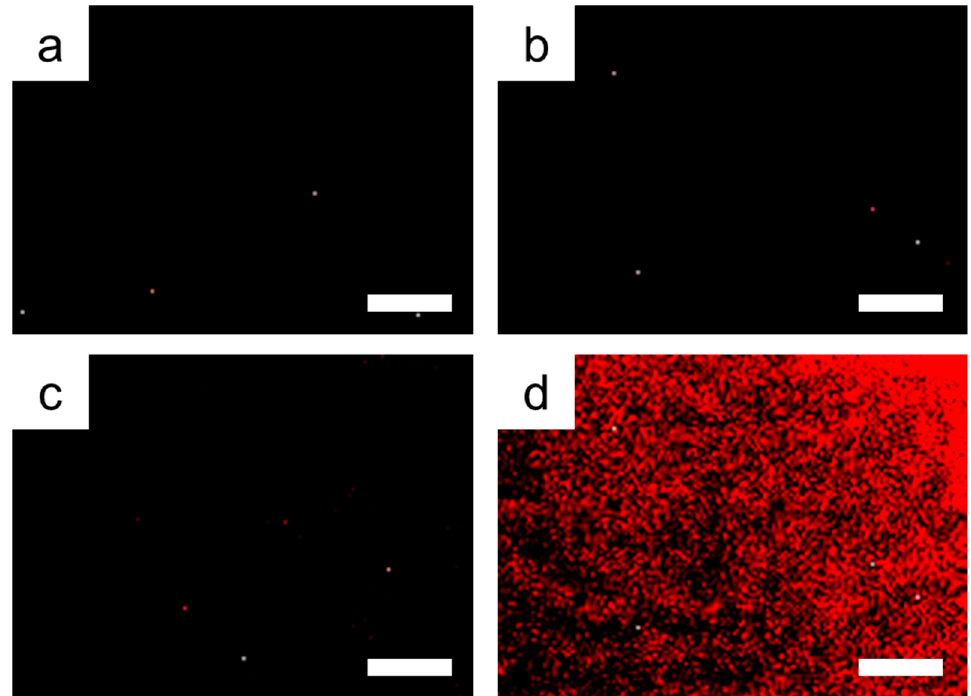
Figure 3. Fluorescence microscopy images of bound aptamers to diazinon-containing sol-gel-coated AAO membranes. ( a ) Binding test with pristine AAO membrane, ( b ) bare sol-gel-coated AAO membrane, ( c ) non-target atrazine containing sol-gel-coated AAO membrane, and ( d ) target diazinon containing sol-gel-coated AAO membrane. Scale bars denote 300 μ m.